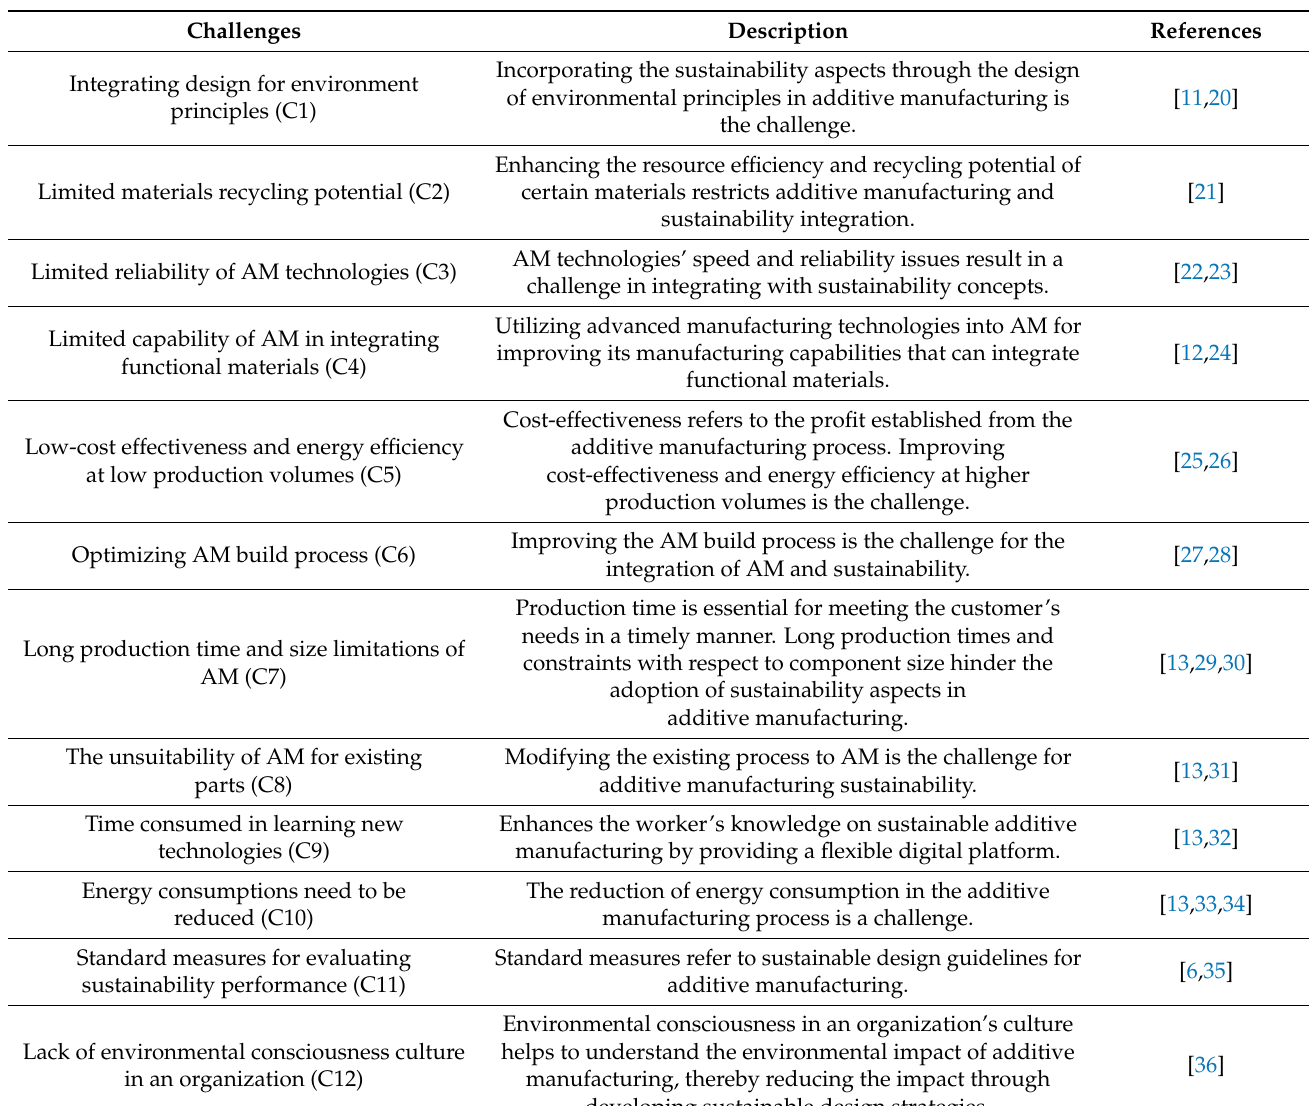
Table 1. Identified challenges for